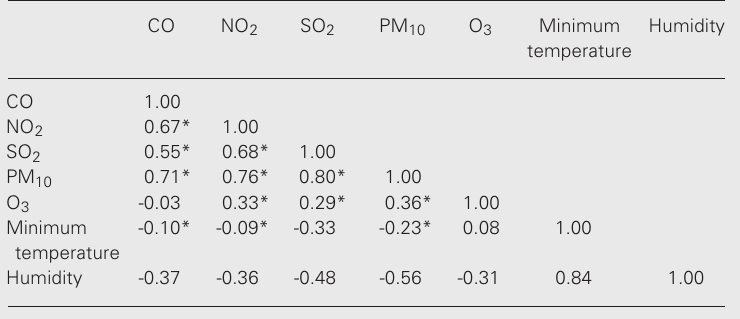
Table 2. Pairwise Pearson correlation coefficients between pollutants and meteoro- logical variables.